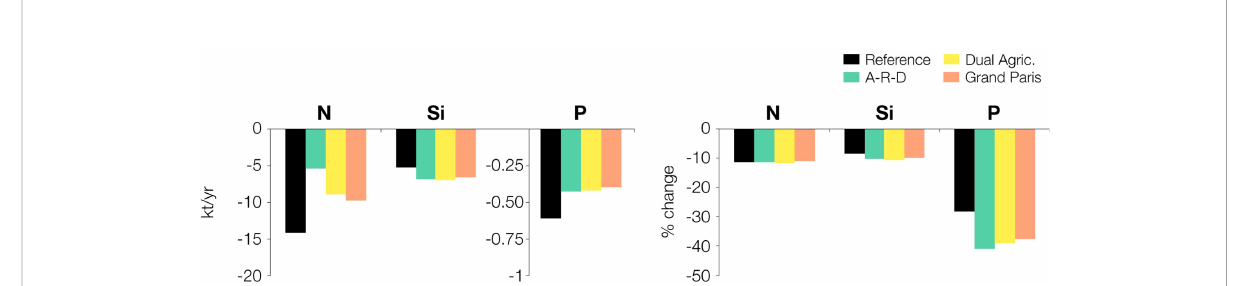
FIGURE 6 Difference in the fl uxes of nitrogen (N), silica (Si) and phosphorus (P) between the inlet (Poses) and the outlet (Le Havre) of the Seine estuary (left, in Kt/year and right, in